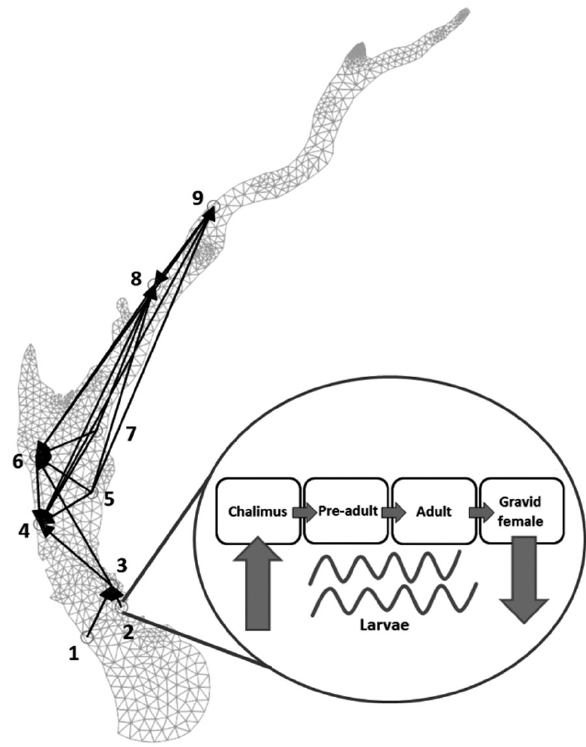
Fig. 1. Model schematic. The basic model was a network of 9 subpopulations of sea lice, each obeying the dynamic equations described by Revie et al. (2005) (see Eq. 1), con- nected by matrices defining inter-site dispersal probabili- ties. The locations of the sites are overlaid here on the hydrodynamic model mesh used to compute dispersal prob- abilities within Loch Fyne, Scotland (see Adams et al. 2012). Connections between sites in this diagram are indicative ex - amples; 81 different connections (including self-connections) are possible in